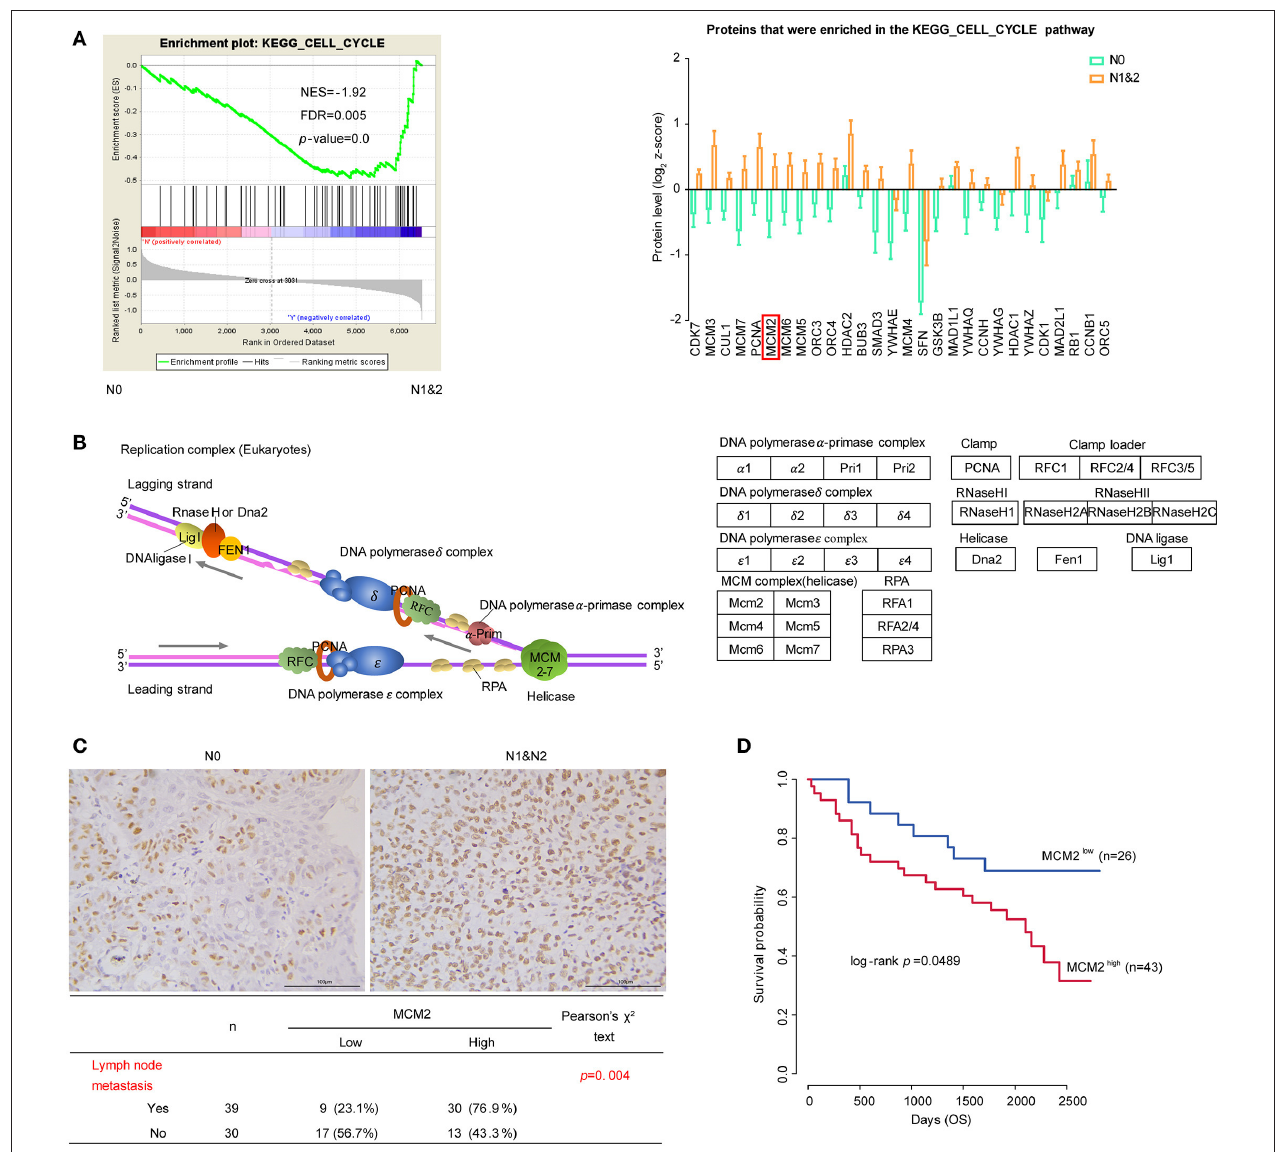
FIGURE 5 | Cell cycle and DNA replication in LUSC based on LNM. (A) Cell cycle pathway and proteins that were enriched in the pathway. The protein quantifications are presented as mean ± SEM. (B) The diagram of DNA replication in cell cycle. Different protein complexes are represented in different colors. (C) The relationship MCM2 protein expression and LNM in tissue microarray (TMA) assay. (D) MCM2 expression and survival analysis in tissue microarray (TMA) assay. Chi-square test was adopted for the correlation analysis, and Kaplan–Meier plot (Log-rank test) was adopted to describe overall survival (OS)